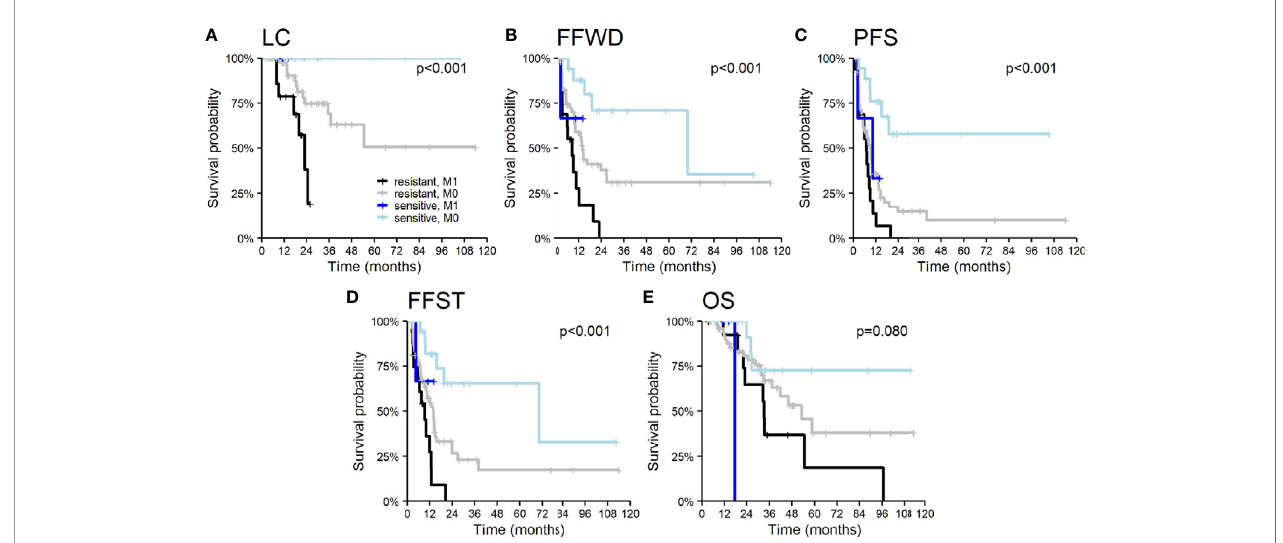
FIGURE 3 | Kaplan – Meier curves according to radiosensitivity of primary tumor and timing of initial dissemination for (A) local control, (B) freedom from widespread dissemination, (C) progression-free survival, (D) freedom from systematic treatment, and (E) overall survival. The p-values given correspond to the appropriate overall test for the multivariable model.